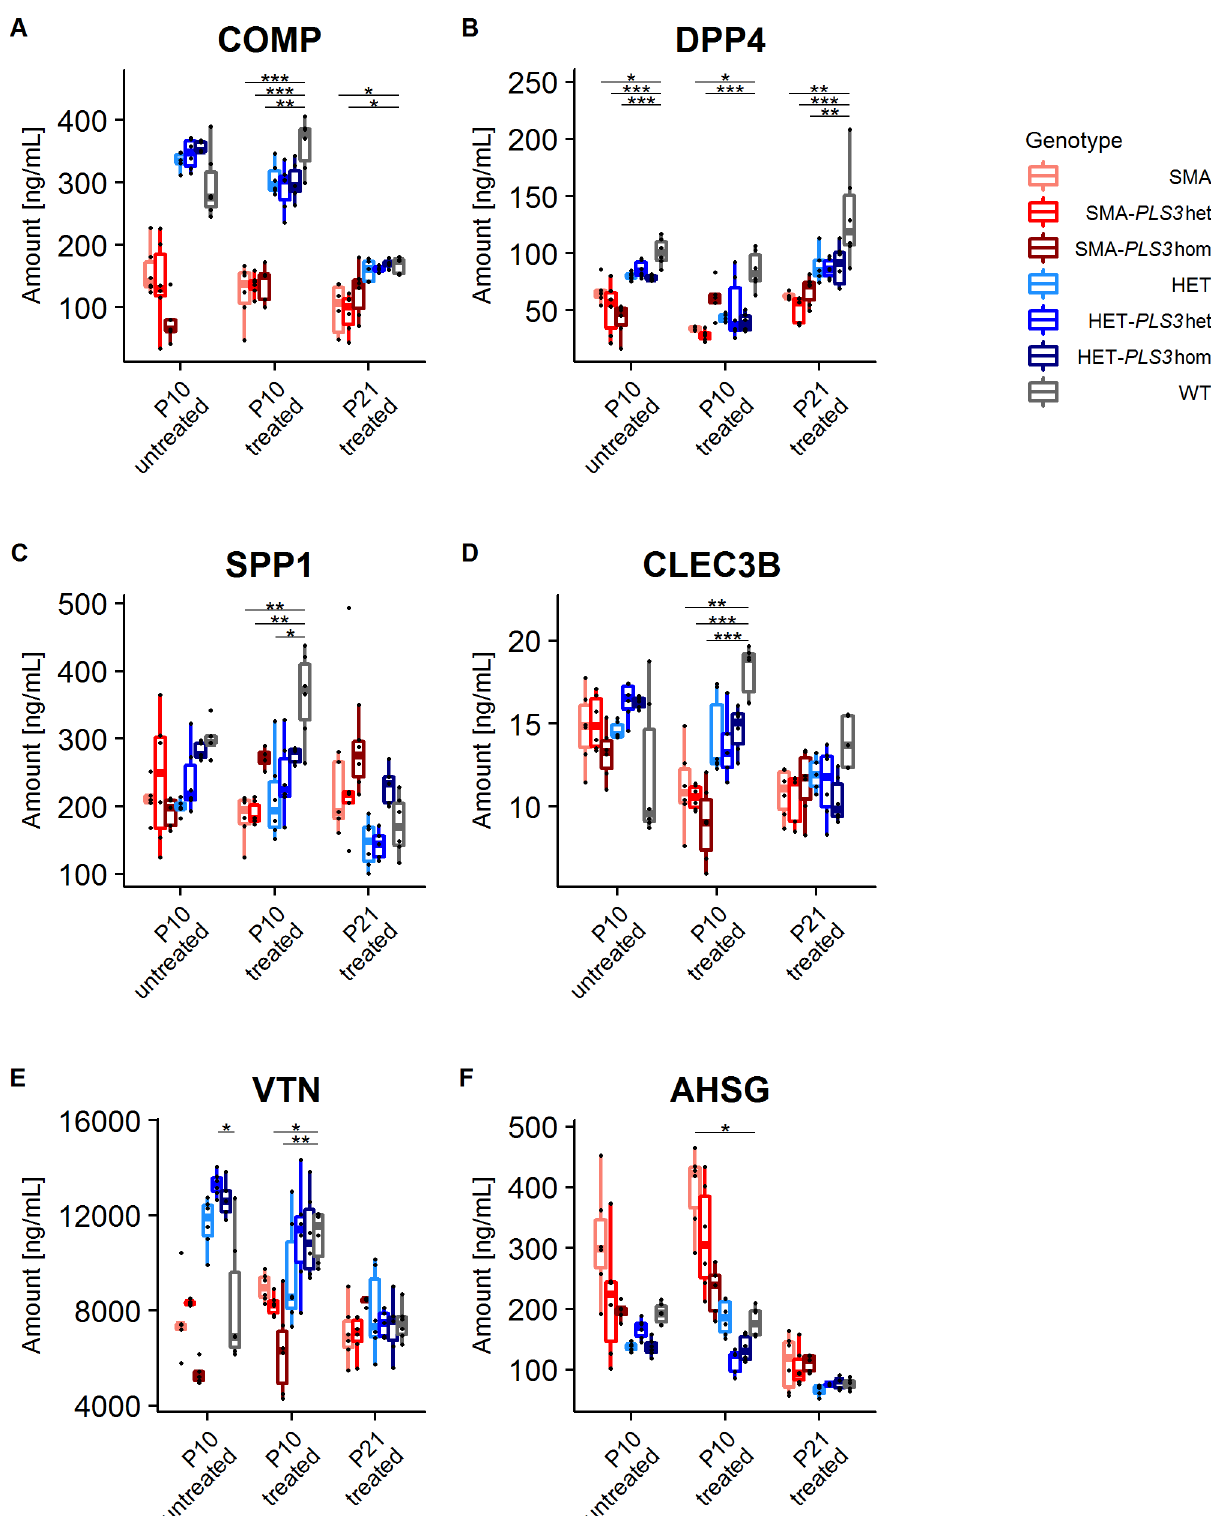
Fig 3. Single group comparison for protein plasma concentrations of six putative biomarkers. Multiple comparisons of untreated and ASO-treated SMA and HET groups with and without PLS3 overexpression at P10 and P21 showing (A) COMP, (B) DPP4, (C) SPP1, (D) CLEC3B, (E) VTN and (F) AHSG concentrations in comparison to WT and WT+ASO, respectively (see also Table 1). (Dunn tests, Holm-corrected for multiple comparisons). Only comparisons leading to a significant difference are shown ( (cid:3) P (cid:20) 0.05; (cid:3)(cid:3) P (cid:20) 0.01, (cid:3)(cid:3)(cid:3) P (cid:20) 0.001).